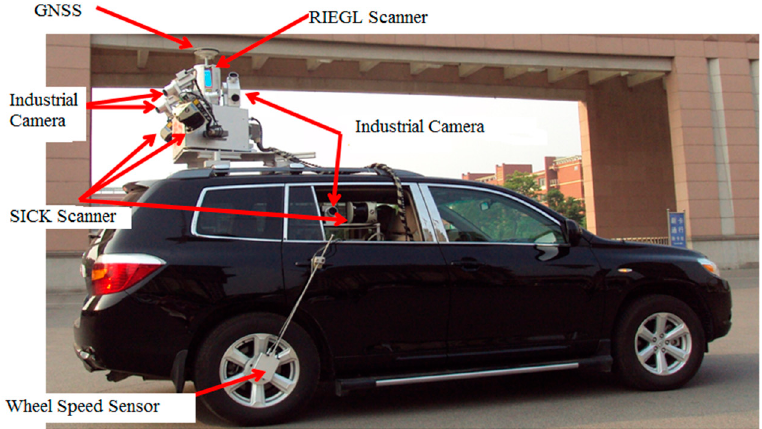
Figure 13. V-Surs I vehicle-borne three-dimensional mobile surveying system.